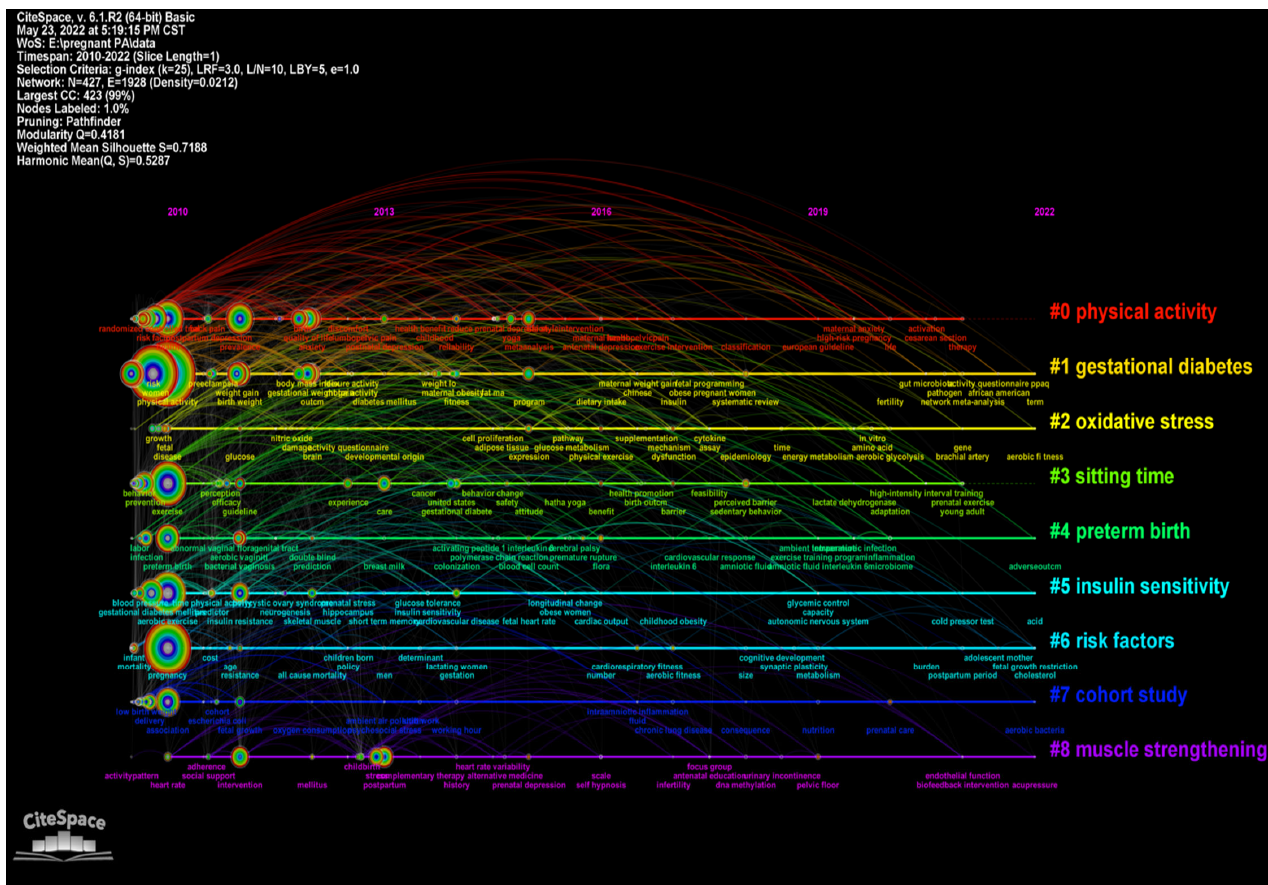
Int. J. Environ. Res. Public Health 2022 , 19 , 14516 Figure 8. Cluster map of keywords in research on physical activity during pregnancy.